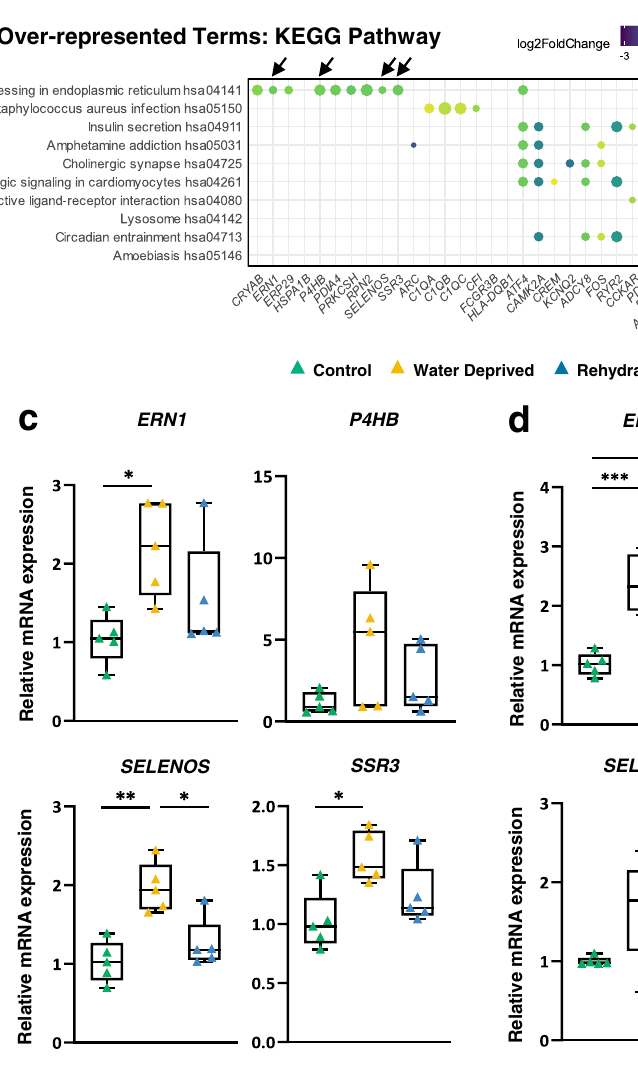
Gene Ontology of DEGs in the SON of WD camel . Gene ontology (GO) analysis was performed on SON DEGs identi fi ed by RNAseq to characterize gene categories, biological processes and networks which potentially participate in the SON plasticity associated with long-term WD (Fig. 6). The Gene Ontology Biological Processes (GO: BP) 31 and Kyoto Encyclopaedia of Genes and Genomes (KEGG) 32,33 databases were applied for GO